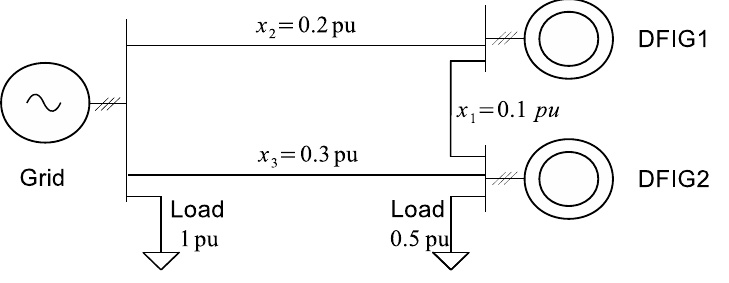
Figure 13. Modeled 3-node grid with 2 DFIGs.